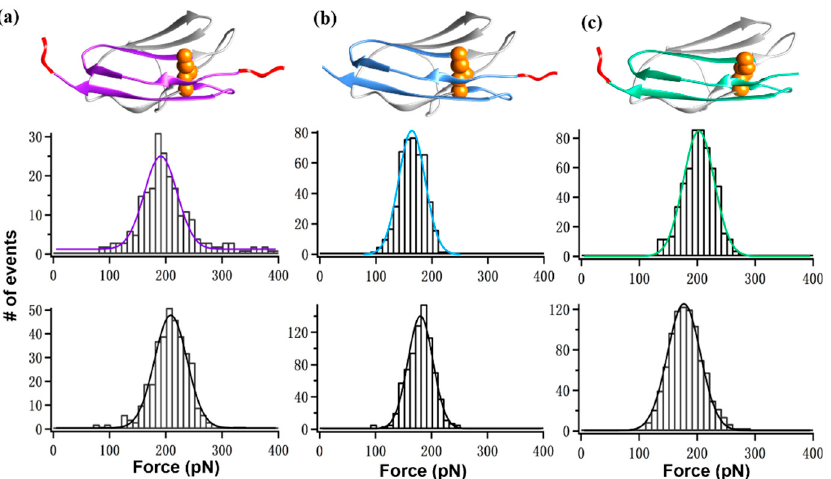
Figure 5. ( a – c ) The scheme (top panel) and mechanical force of I30 in polyprotein I(27–32) ( a ), I(28–30) ( b ), and I(30–32) ( c ). The unfolding force histogram of I30 with the corresponding linker is shown in the middle panel, and the natural sequence without linker is shown at the bottom. The 9G linker was colored red, and the two cysteines forming the disulfide bond were depicted as orange spheres. Table 2. Unfolding force of I30 in each polyprotein